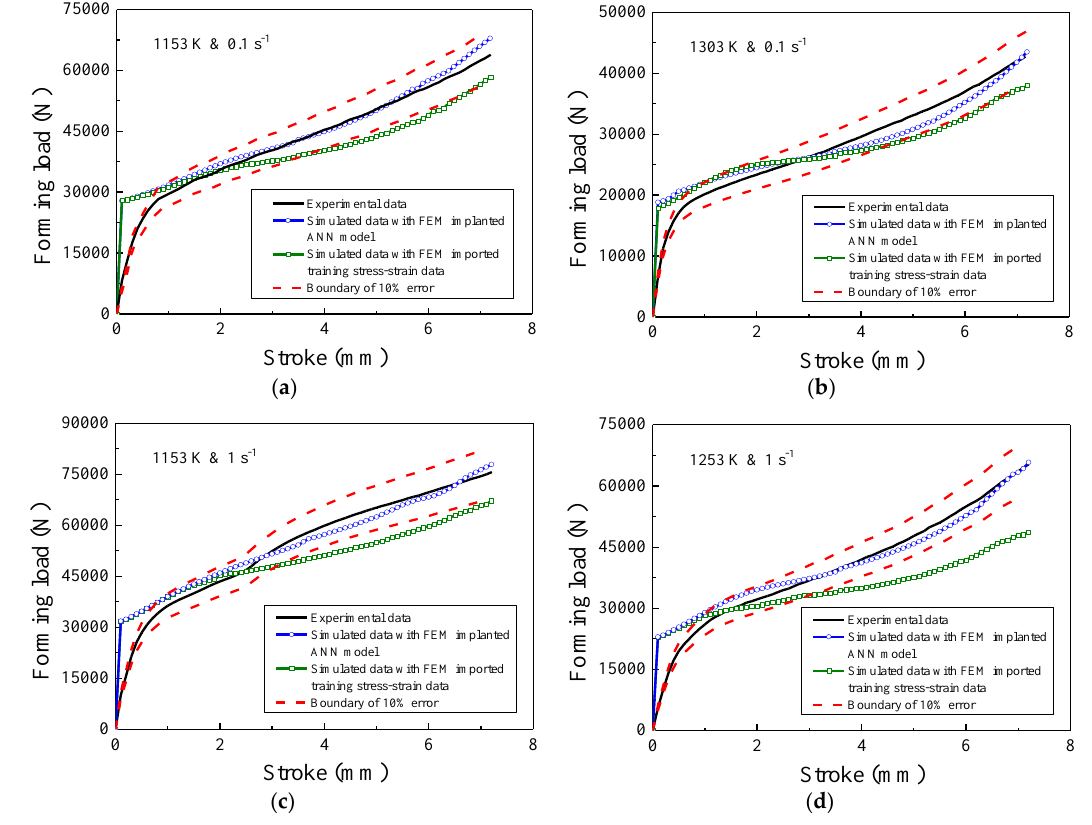
Figure 15. Comparisons between the predicted and experimental stroke-load curves under the deformation conditions of ( a ) 1153 K and 0.1 s −1 ; ( b ) 1303 K and 0.1 s −1 ; ( c ) 1153 K and 1 s −1 and ( d ) 1253 K and 1 s −1 .